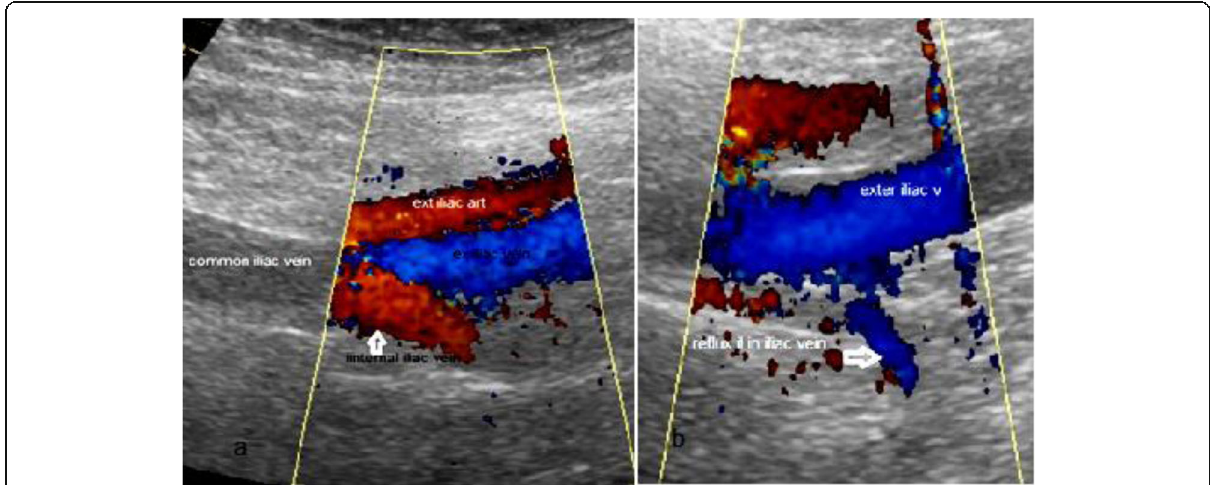
Fig. 7 a , b Trans-abdominal color Doppler images showing a competent proximal traceable portion of the internal iliac vein (coded in red) in ( a )